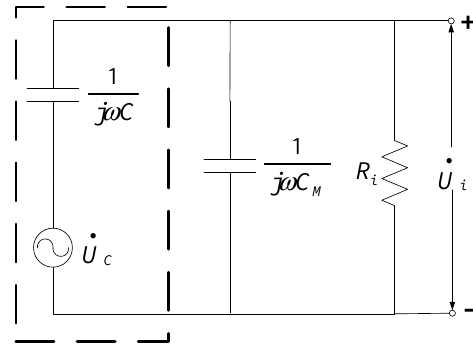
Figure 1. Equivalent circuit of the measuring system.